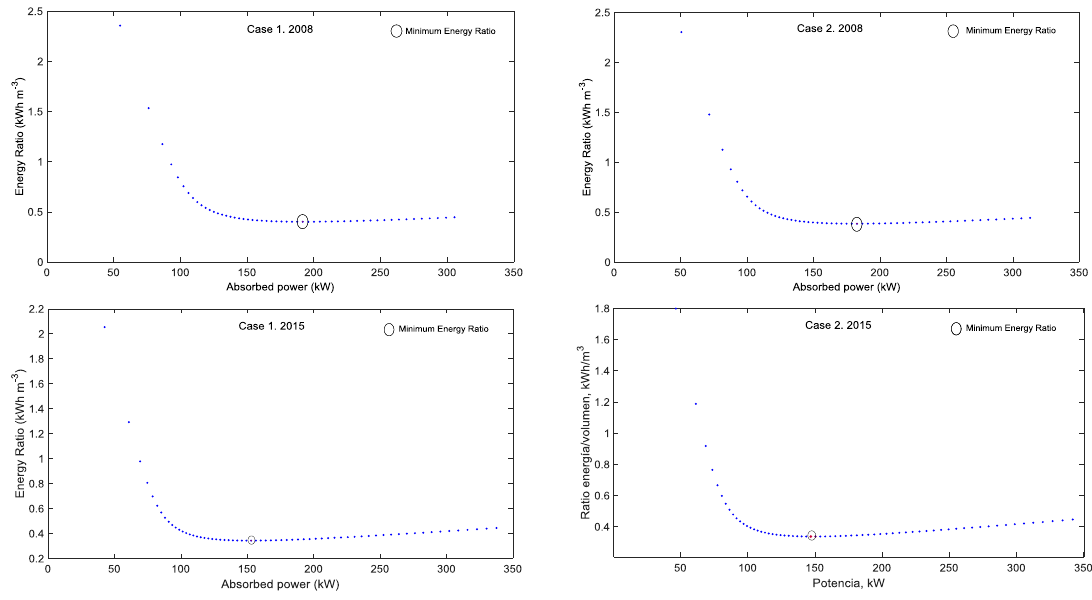
Figure 7. Energy ratio (kWh m −3 ) at each variable speed ratio ( α) in WUA A.